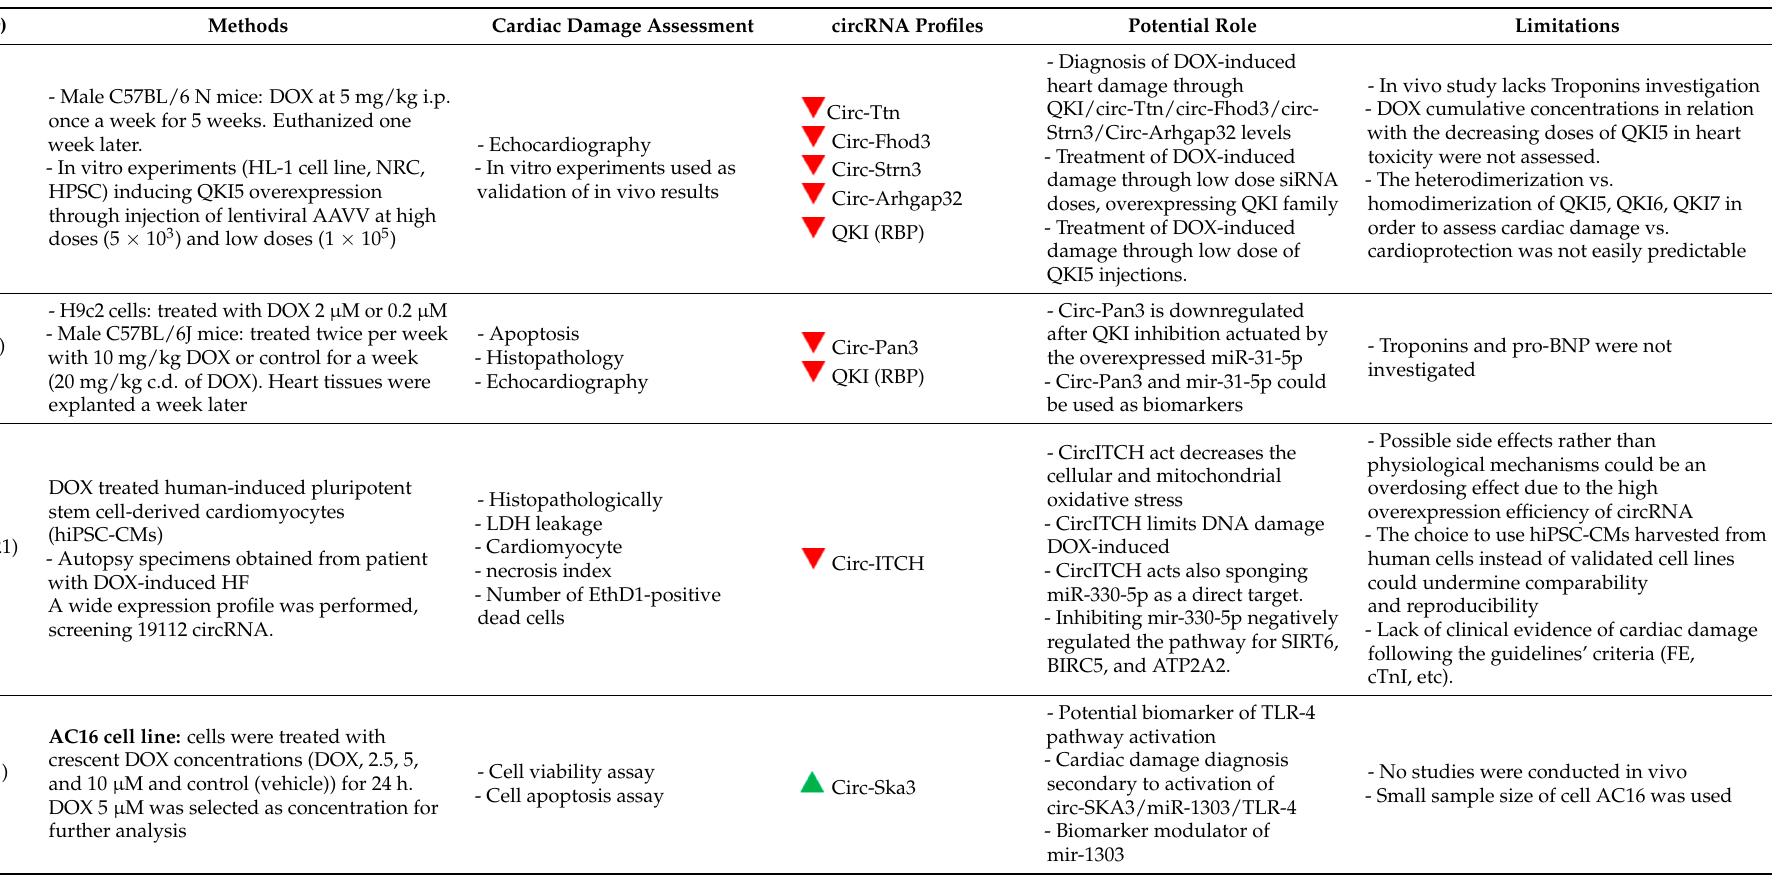
Table 2. Studies focused on circRNAs in the Cardiotoxicity